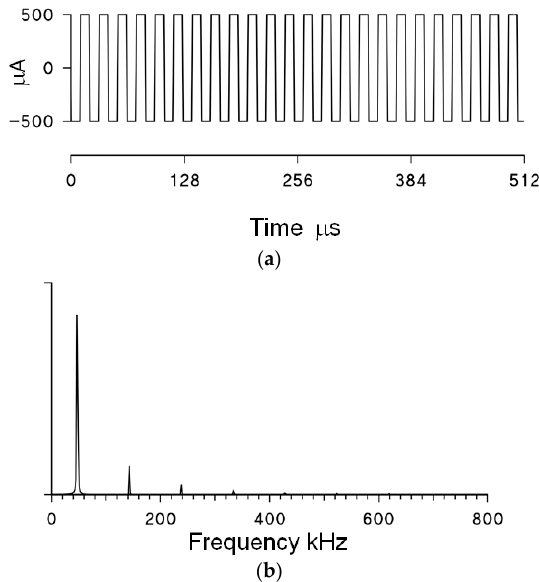
Figure 2. ( a ) Example of stimulation current at f 0 = 48 kHz (for clarity, only a segment of the original 5-ms-long train of square waves is shown); ( b ) Modulus of the corresponding FFT spectrum; the Fourier spectrum shows a main peak at the fundamental frequency f 0 , and minor peaks at higher harmonics (note that the amplitude of even harmonics is zero for the square wave). Only the Fourier component at f 0 is considered for the estimation of Z (f) .